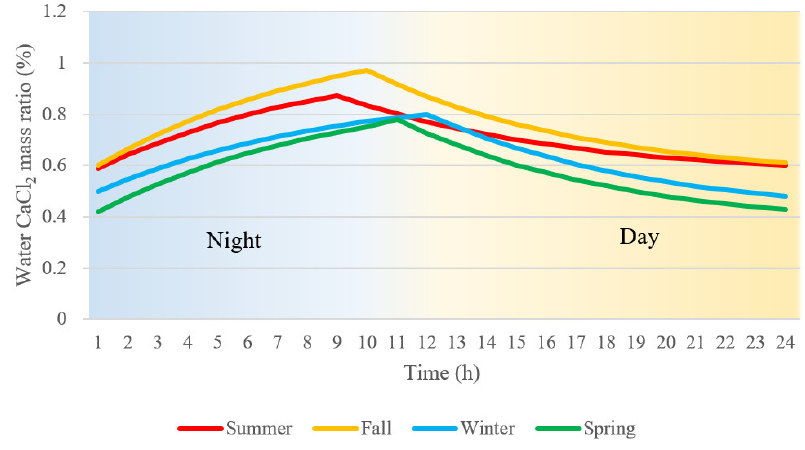
Figure 17. Seasonal simulation scenarios in Jeddah, KSA.